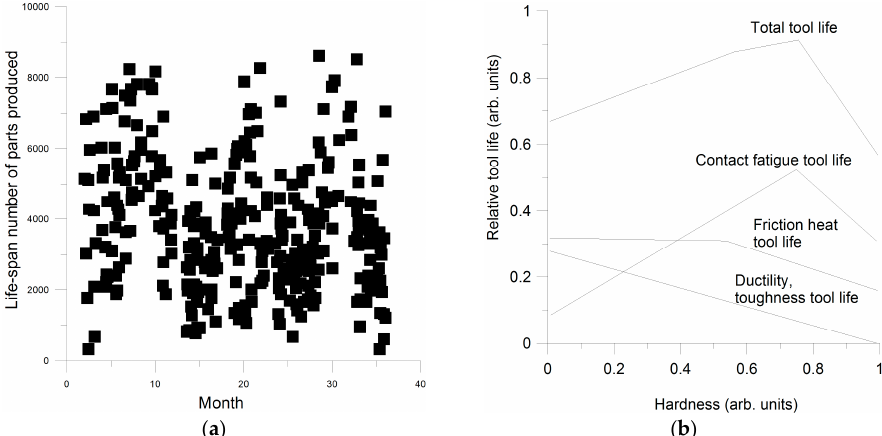
Figure 1. Tool life, ( a ) data of life spans of individual tool inserts over time illustrating the large variation observed under industrial practice conditions, after ref. [5]; ( b ) schematic relation between toll hardness and reasons for failure in tooling after ref. [6].